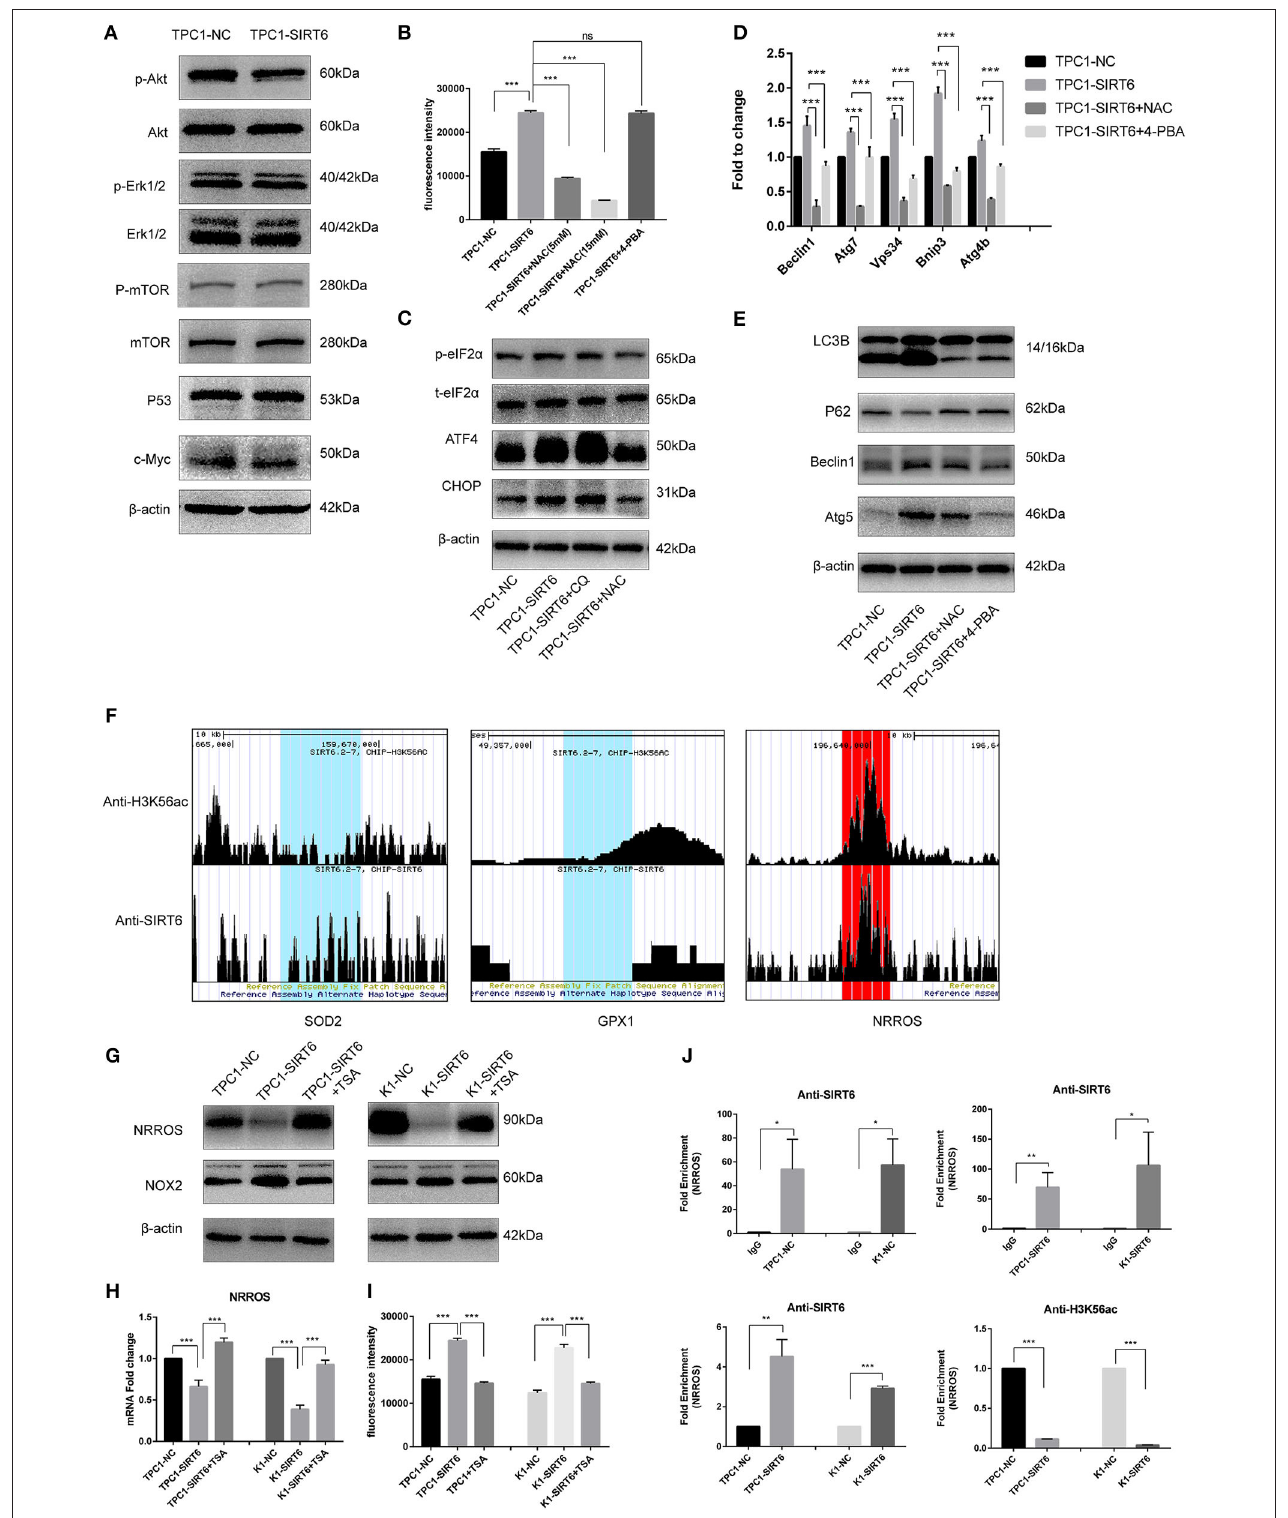
FIGURE 2 | SIRT6 promoted autophagy via ROS-induced ER stress. (A) Levels of proteins involved in common autophagy-associated pathways (AKT/mTOR and ERK/mTOR) and transcription factors (P53 and c-Myc) in TPC1-SIRT6 and TPC1-NC cells. (B) ROS production in TPC1-NC, TPC1-SIRT6, and TPC1-SIRT6